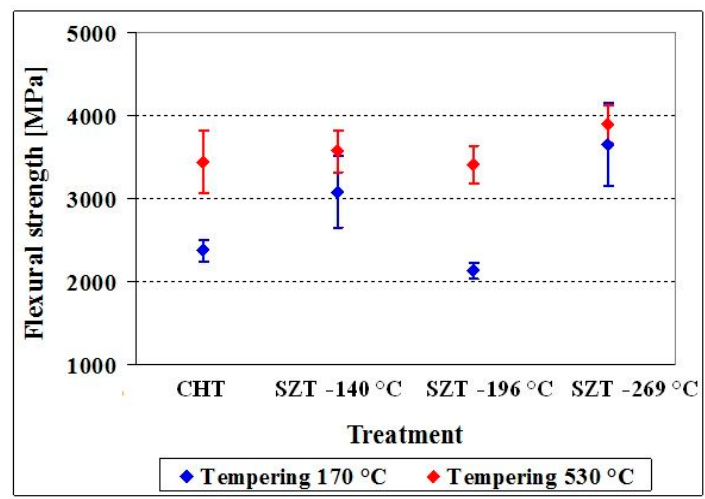
Figure 7. Flexural strength for CHT and differently SZT treated specimens made of Vanadis 6 steel.